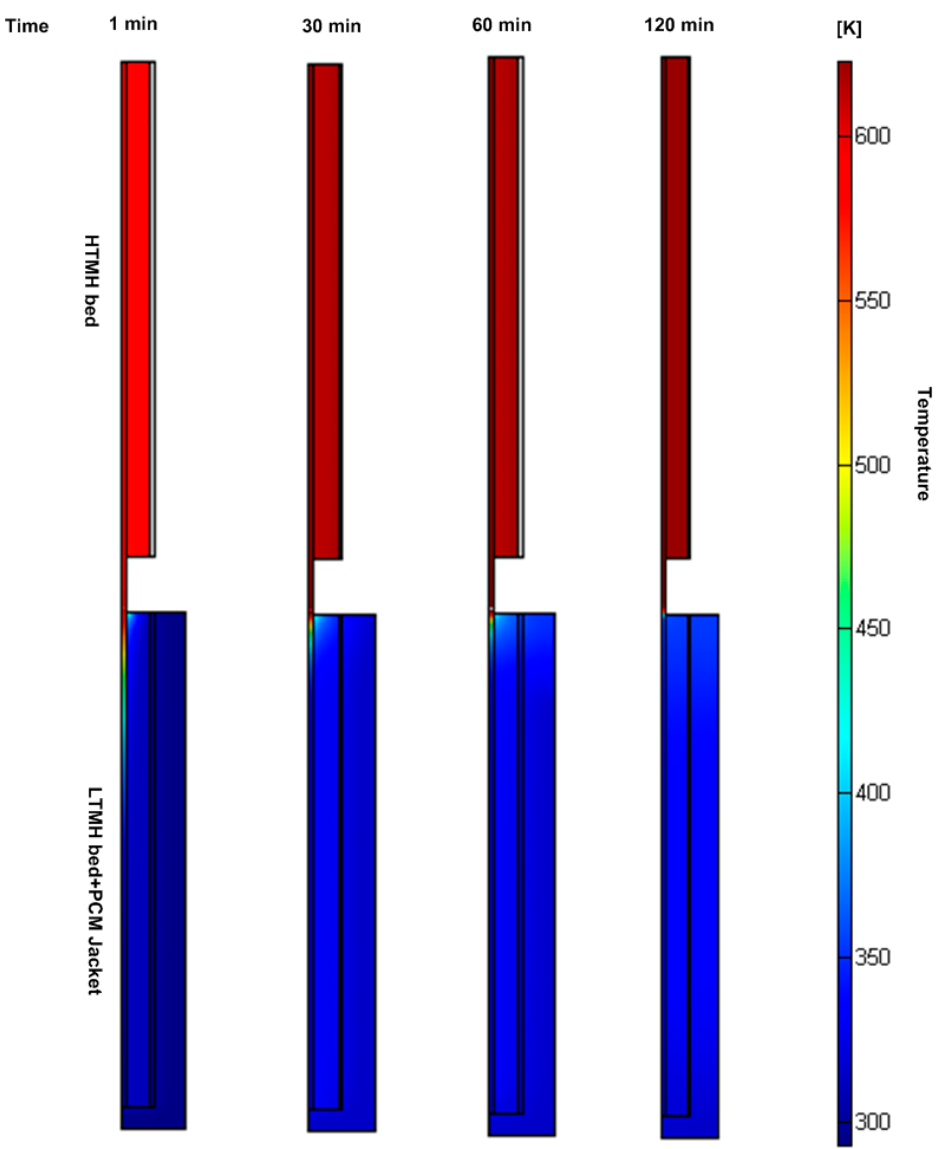
Figure 9. Temperature spatial distribution in the control volume at selected time (1, 30, 60 and 120 min) during the heat charging.